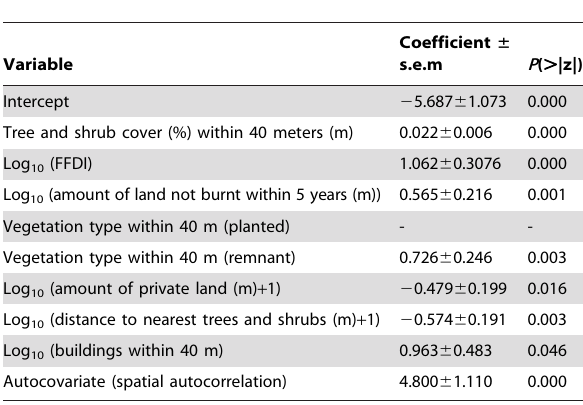
Table 1. The selected logistic regression model used to predict the proportion of houses lost during the sampled